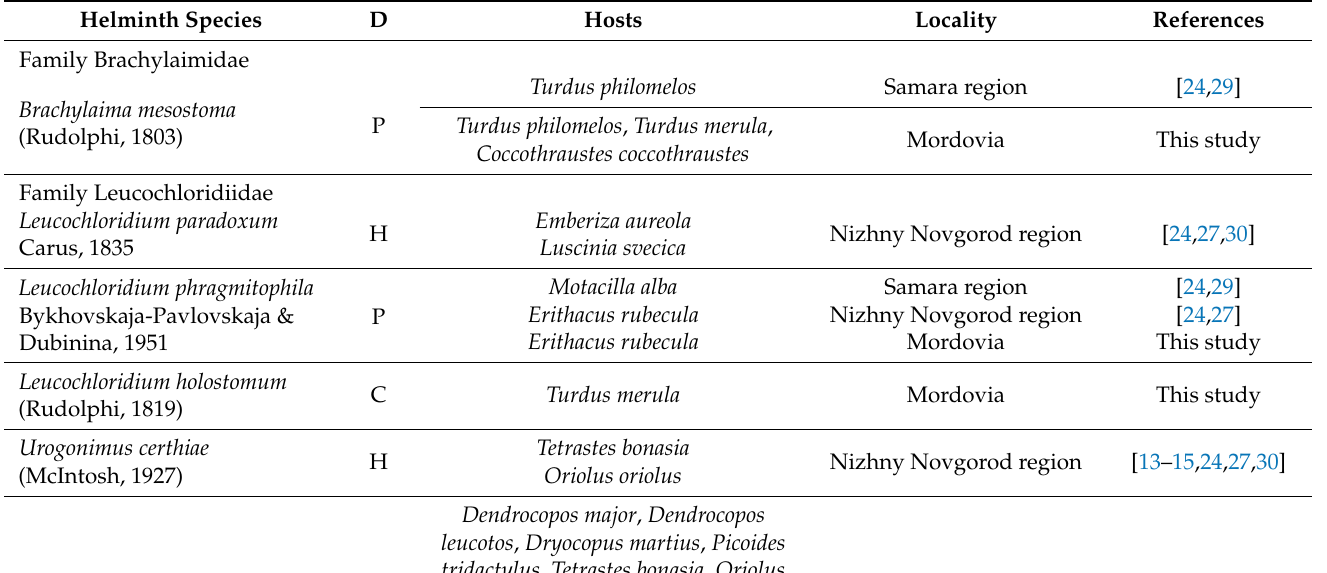
Table 2. List of trematodes reported from land birds from the Middle Volga region (European